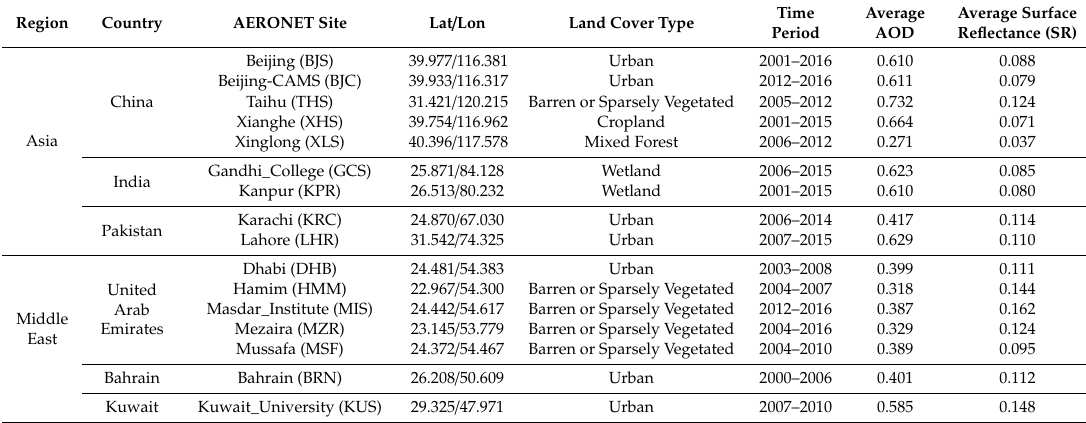
Figure 1. The geographical location of the study area. ( a ) The locations of the 23 AERONET sites are used for the evaluation of the satellite-based AOD products by circulars, and ( b ) the spatial distribution of all AERONET sites in the world. Background map is global annual average surface-level PM 2.5 concentration derived from MODIS and MISR AOD satellite data sets (2001–2010) [32]. Table 1. AErosol RObotic NETwork (AERONET) Level 2.0 data used in this study .